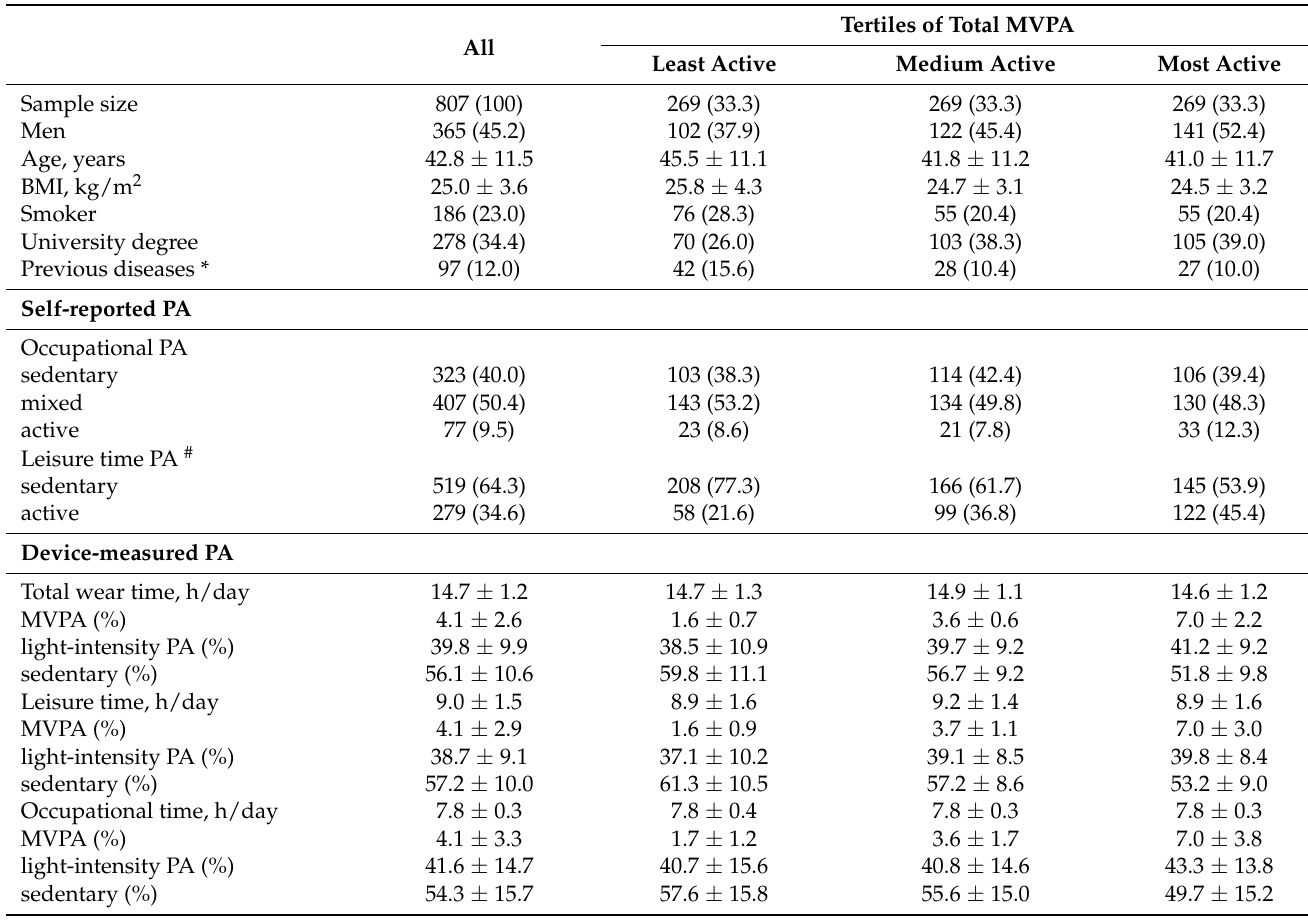
Table 1. Baseline characteristics of the full study sample and by tertiles of device-measured moderate-to-vigorous physical